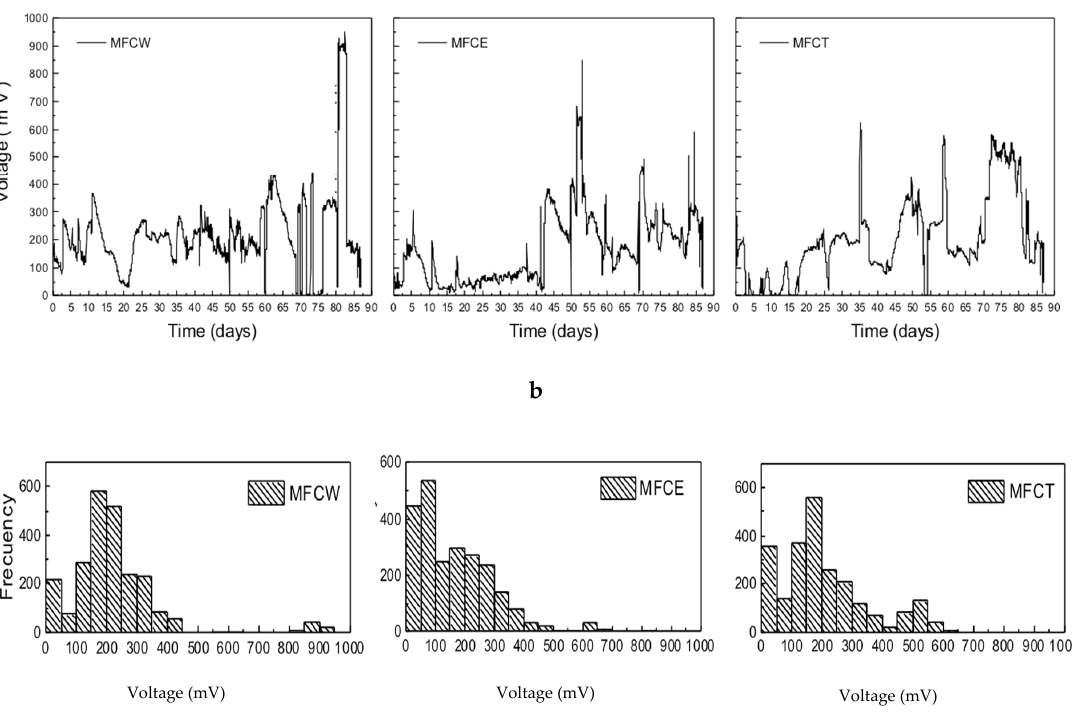
Figure 2. ( a ) Voltage in microbial fuel cells, ( b ) frequency of generated voltages.